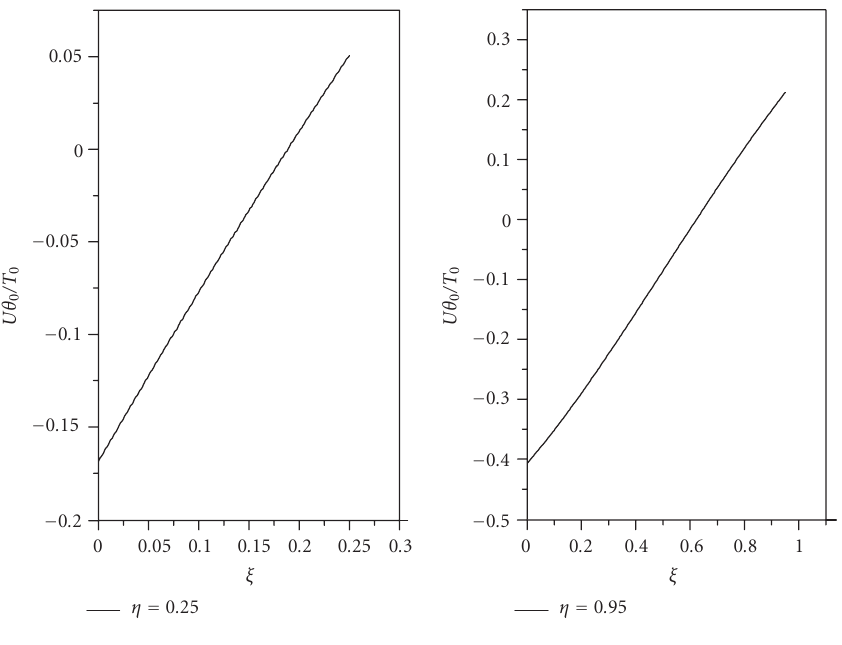
Figure 3.1. Displacement versus distance.